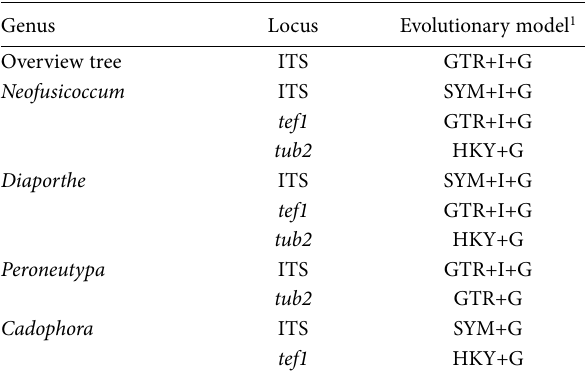
Figure 7. Morphological characteristics of the front and reverse sides of colonies of the different fungal species grown 10 d on PDA.